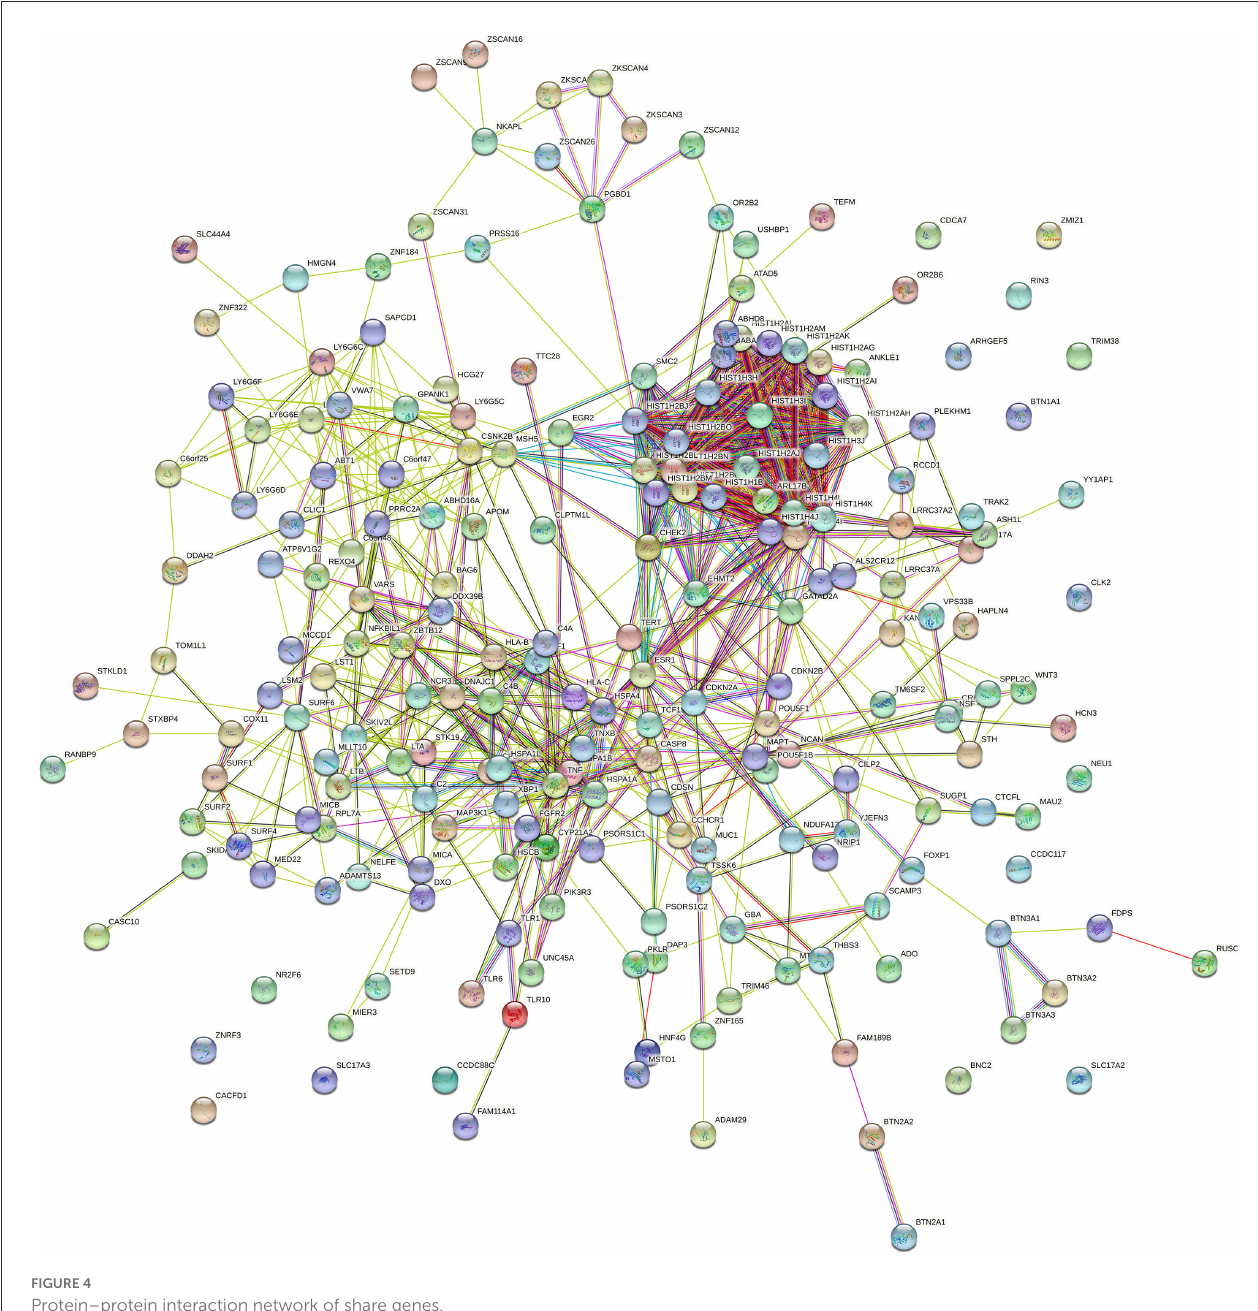
FIGURE4 Protein–protein interaction network of share